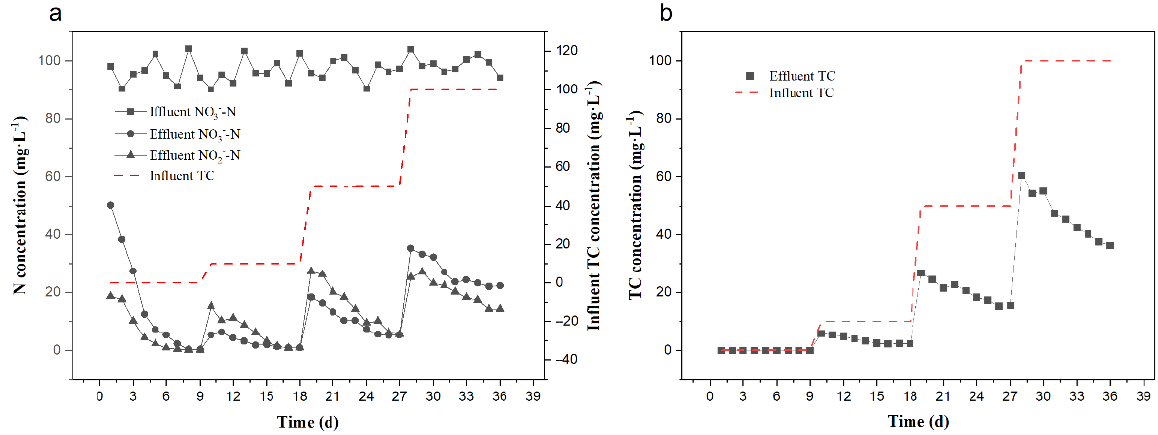
Figure 2. ( a ) Denitrification performance and ( b ) TC removal under different initial TC concentra- tions.